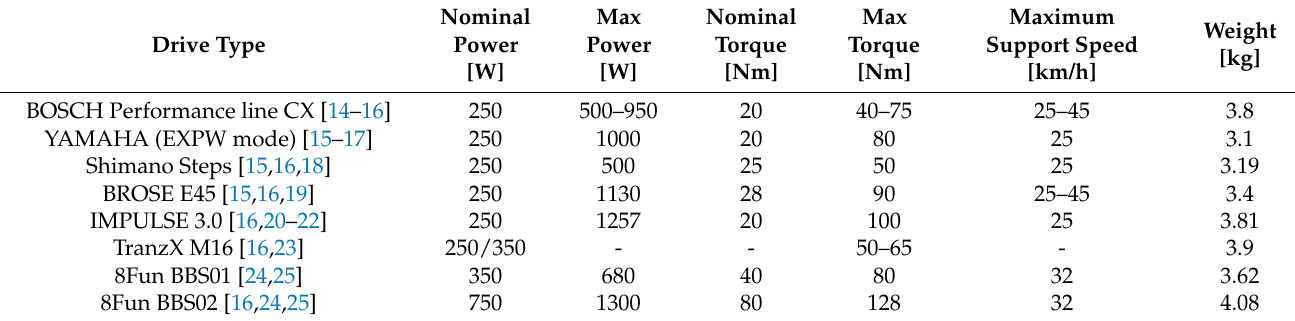
Table 1. Main characteristics of existing mid-drive e-bike